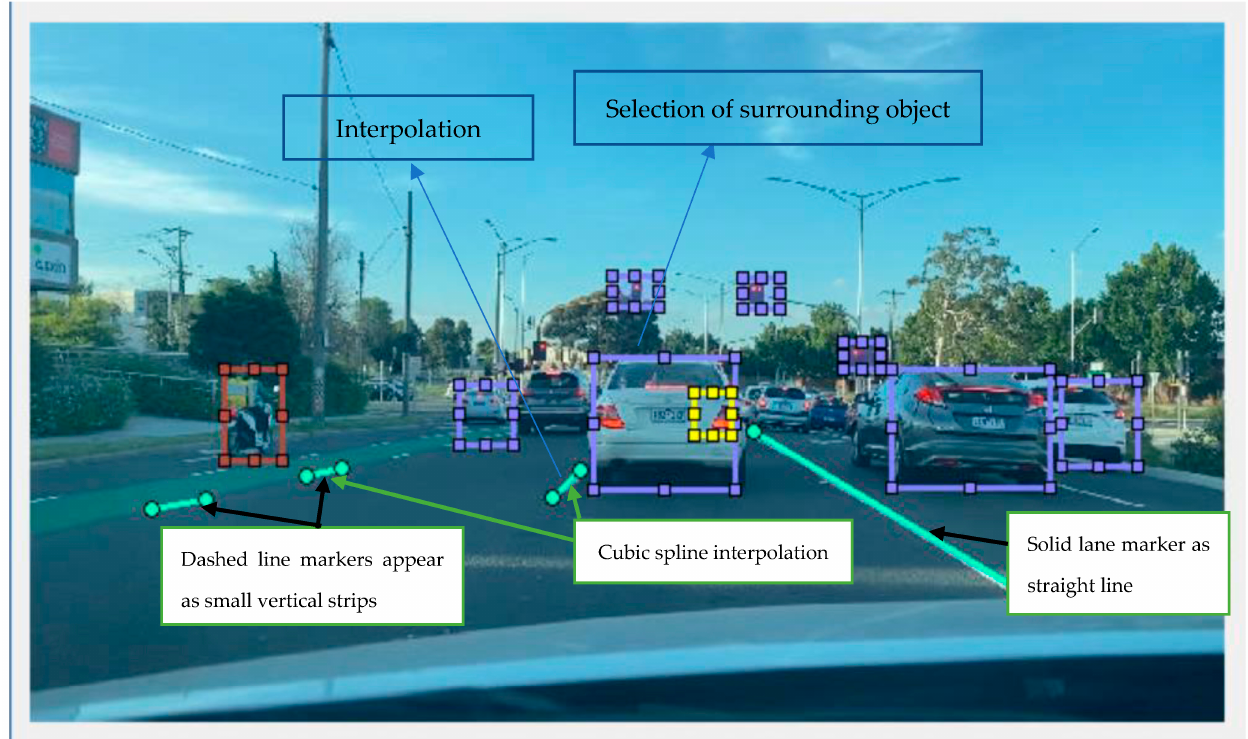
Figure 4. In the interpolation image, curve fitting estimates lane marker positions between the annotated points (p1, p2, p3, along the yellow line), as shown in Figure 4. Step 3: